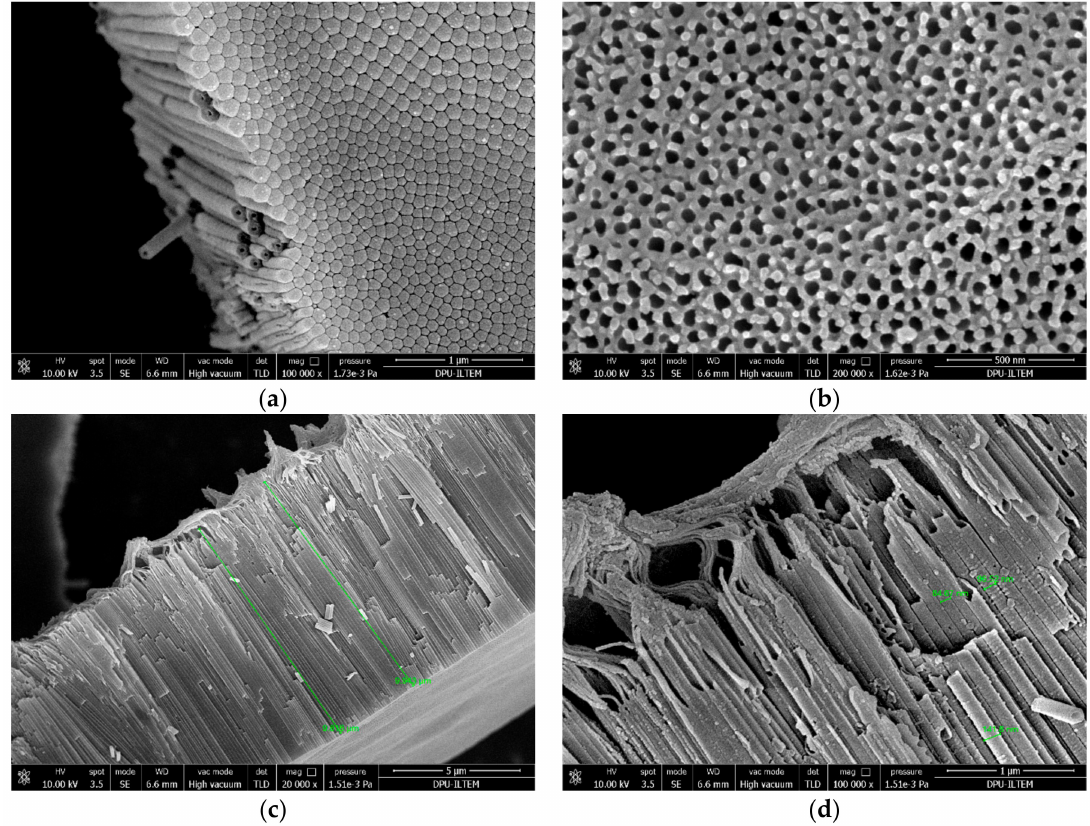
Figure 7. SEM images of Ti/TiO 2 NTEG-4h-500 photoanode: ( a ) bottom view (magnification: 100,000 × ); ( b ) top view (magnification: 200,000 × ); ( c ) cross–section view (magnification: 20,000 × ); and ( d ) cross–section view (magnification: 100,000 ×